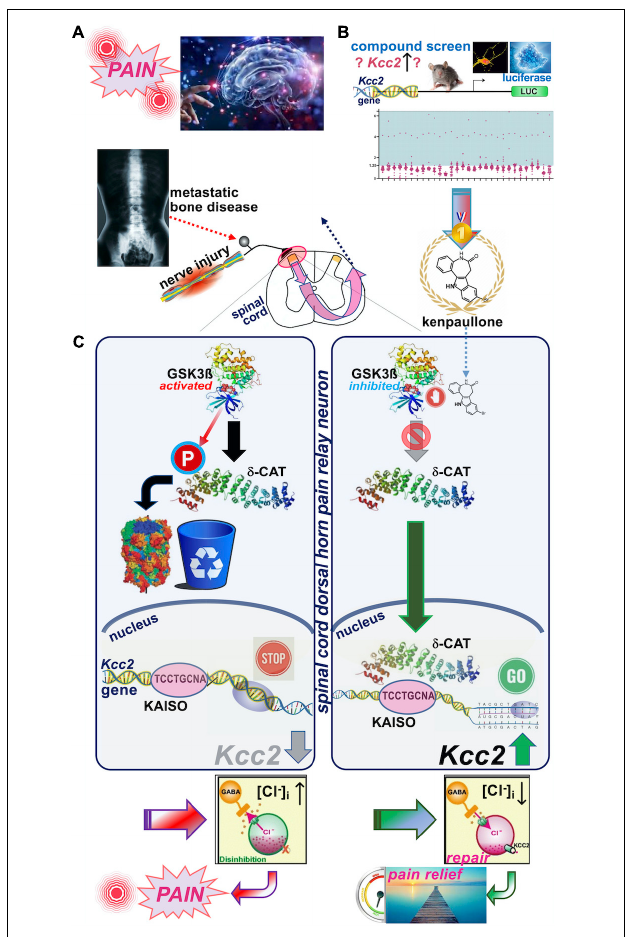
FIGURE 2 | Schematic overview of the recent discovery of kenpaullone as Kcc2 gene expression-enhancing compound. (A) Upper left. Nerve injury pain and bone cancer pain are serious and pressing unmet medical needs. Preclinical models were used to test kenpaullone, which proved highly effective in both. (B) Upper right. “Junkyard of cancer” drugs were screened for their potency to enhance Kcc2 gene expression, using primary neurons derived from newborn mice cerebral cortexes. The Kcc2 promoter, in these neurons, was driving luciferase (LUC), so that LUC could serve as a primary screening read-out. Kenpaullone was identified as a “winner,” capable of switching on the Kcc2 gene, which previous research predicted to be beneficial for chronic pain. (C) Middle panels, left-hand: Nerve injury by constriction or cancer cells populating a bone activates GSK3 β , an enzyme that tags other proteins with phosphate. In nerve cells dedicated to pain relay in the spinal cord, GSK3 β tags delta-catenin ( δ -CAT), which routs δ -CAT to the cellular garbage bin. Without δ -CAT in the cells’ nucleus, the Kcc2 gene remains switched off. This in turn makes the pain relay neurons run full of chloride, which makes them electrically more jittery, with chronic “refractory” pain as a result. Right-hand panel: Treatment with kenpaullone inhibits GSK3 β ’s phosphate-tagging capability, so that δ -CAT becomes untagged, which clears the way to the nerve cells’ nucleus. There it binds to the DNA region of the Kcc2 gene critical for switch-on or switch-off, the promoter. By binding there, δ -CAT reverts the switch-off to switch-on and the Kcc2 gene runs again, making KCC2 protein. KCC2 in turn pumps chloride ions out of the pain-relay nerve cells, making them electrically more stable. This leads to circuit repair and pain relief, based on resetting of the genetic switches. Instead of Kenpaullone, δ -CAT can serve as payload of a gene therapy approach that directs expression of δ -CAT and hence KCC2 to pain relay nerve cells in the spinal